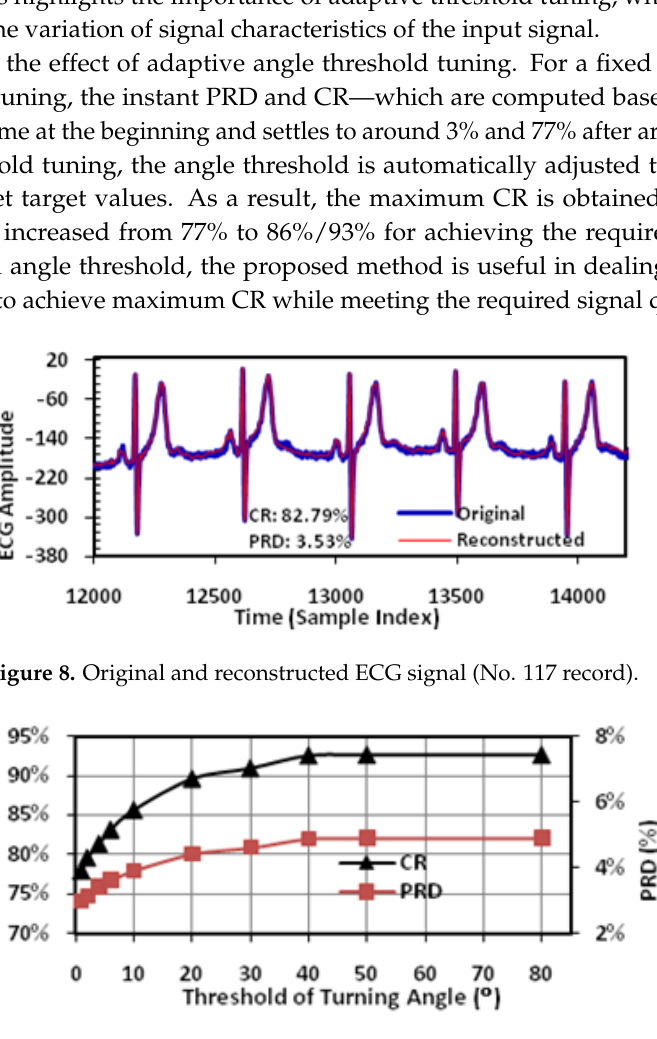
Figure 9. Impact of turning angle threshold on CR and PRD (No. 117 record).